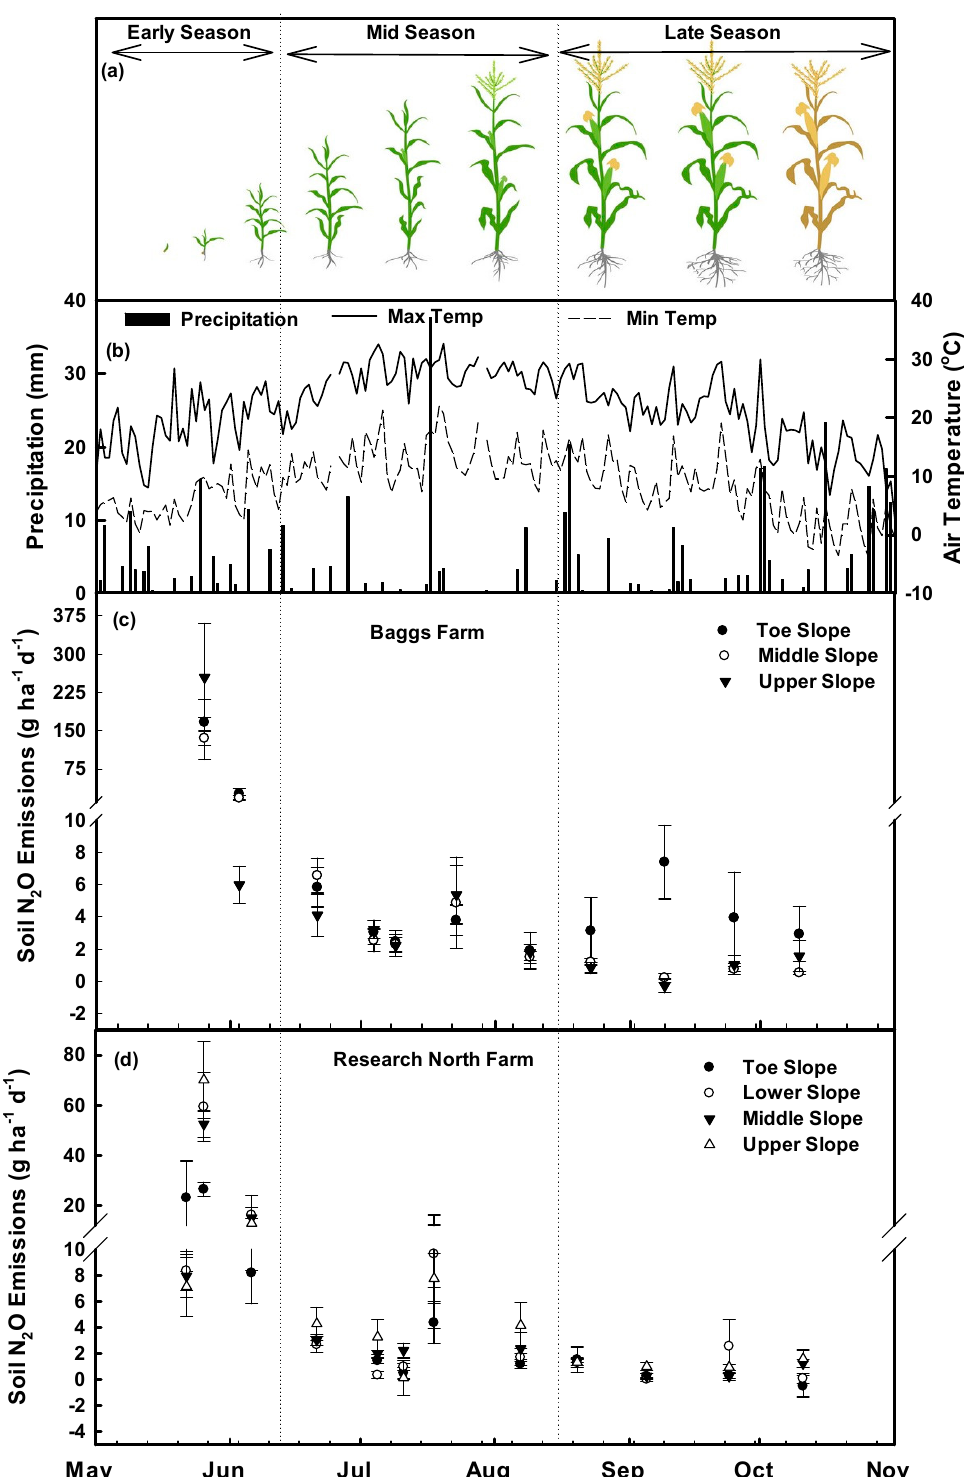
Figure 4. Corn growth seasons ( a ), weather conditions ( b ), and temporal patterns of Soil N 2 O emissions at Baggs farm ( c ) and Research North ( d ). Scatter plots were prepared using mean N 2 O emissions (Mean ± SEM) from four replications at each slope positions. Gas samples were collected from the Baggs farm during early season (26 May, 3 June), mid season (21 June, 4 July, 9 July, 23 July, 9 August) and late growing season (23 August, 9 September, 25 September, 10 October) and from Research North during early (22 May, 26 May, 6 June), mid (21 June, 5 July, 11 July, 18 July, 7 August), and the late growing season (20 August, 5 September, 24 September, 11 October). Image source